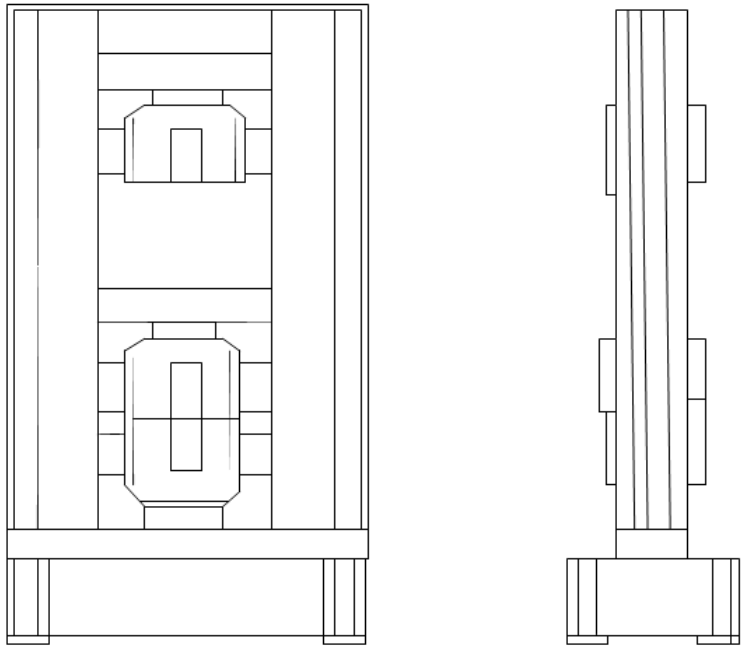
Figure 4. LABTest 6.100 device (front view and side view).